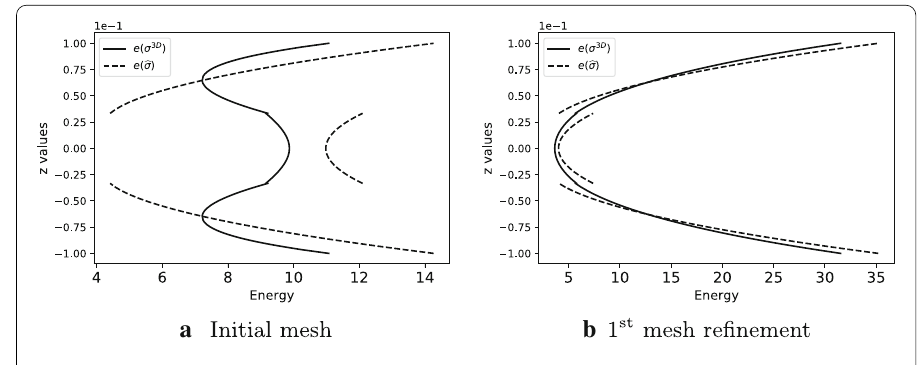
Fig. 2 Energy densities across the plate thickness computed for σ 3 D and (cid:13) σ at the plate center ( n = 3)